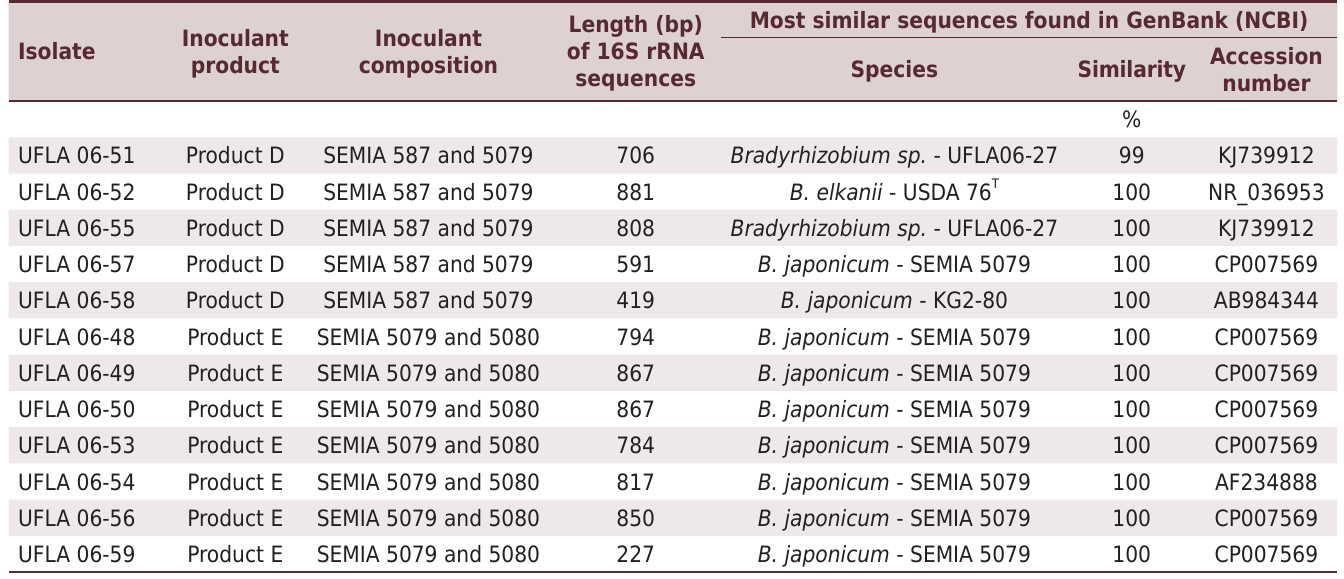
Table 3. Identification by 16S rRNA partial gene sequencing of variant strains isolated from commercial soybean inoculants Isolate